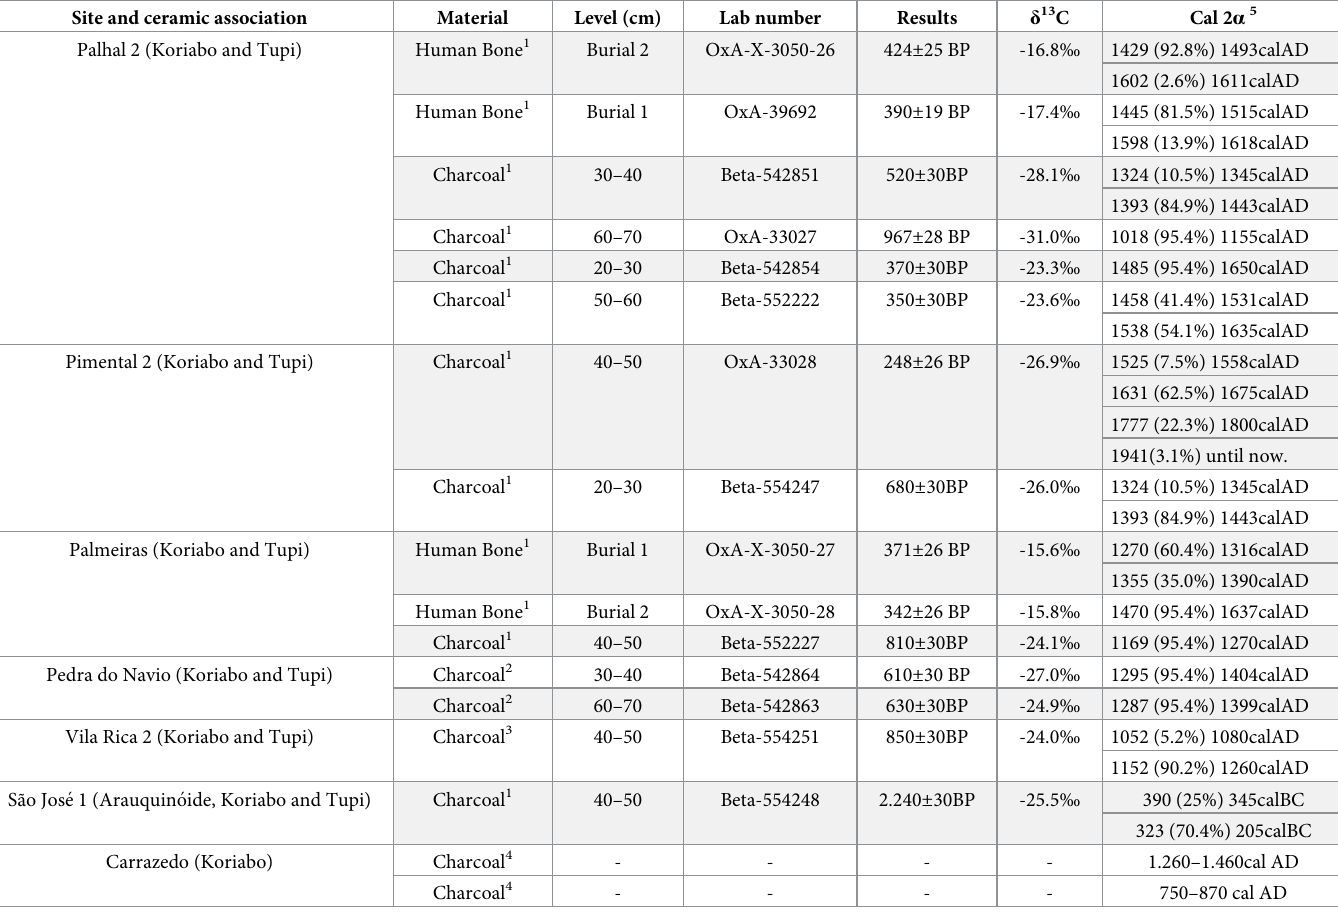
Table 1. Radiocarbon analysis of archaeological sites from which isotope analysis were